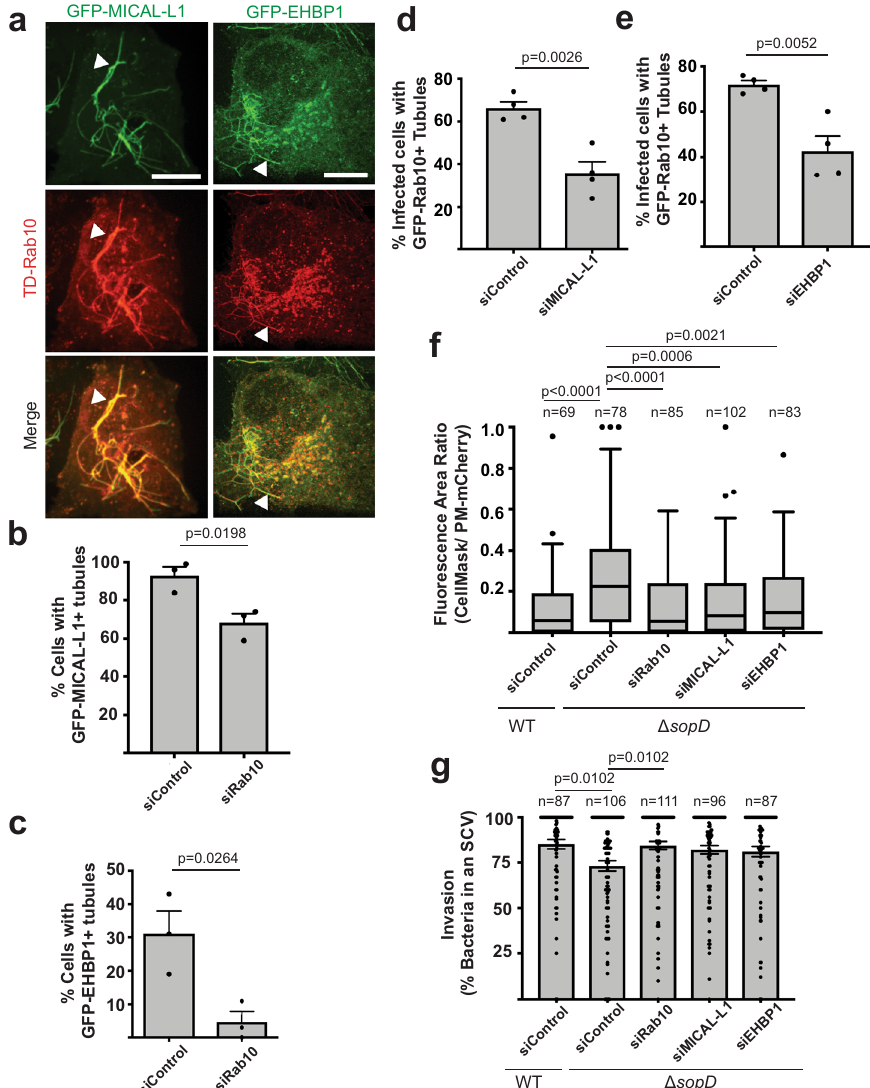
Fig. 4 Rab10 effectors limit scission of the plasma membrane during invasion by Δ sopD mutant S . Typhimurium. a Representative images of Henle 407 live cells co-transfected with TD-Rab10 and GFP-MICAL-L1 or GFP-EHBP1. Arrowheads indicate colocalization on tubules. Scale Bar, 10 μ m. Data are representative of three independent experiments. b , c Quanti fi cation of the presence or absence of ( b ) GFP-MICAL-L1 or ( c ) GFP-EHBP1 tubules under siControl or siRab10 knockdown conditions. At least 100 cells were quanti fi ed in three independent experiments. Data are means± S.E.M. P values determined using a two-tailed unpaired Student ’ s t test. d , e Henle 407 cells were transfected with the indicated siRNA and transfected 24 h later with GFP-Rab10, then infected with Δ sopD mutant S . Typhimurium and fi xed 30 min post-infection. In three independent experiments at least 50 infected cells were quanti fi ed for the presence or absence of GFP-Rab10 + tubules. Data are means ± S.E.M. P values determined using a two-tailed unpaired Student ’ s t test. f Henle 407 cells were transfected with the indicated siRNA (Rab10 siRNA #2, see “ Methods ” ) and then PM-mCherry 24 h later. Cells were then infected with BFP expressing WT or Δ sopD mutant Salmonella for 20 mins and labelled with CellMask. The fl uorescence area labelled with CellMask compared to that labelled with PM-mCherry is used as an index of sealing at the invasion site. Data are visualized with Tukey-style boxplots, where the boxes represent the 25th, 50th/median and 75th percentiles. The whiskers denote 1.5x the IQR (interquartile range) from the median. Points denote outliers beyond 1.5 x IQR. Statistical analysis was performed with one-way ANOVA. P -values and the number of independent cells used for measurements ( n ) are indicated in the fi gure. g Invasion represented as the percent of bacteria in Salmonella -containing vacuoles. The total number of bacteria that were positive for PM-mCherry at the invasion site was quanti fi ed and the proportion of these bacteria that were negative for CellMask was determined. These bacteria were in a sealed compartment that was considered an SCV and the number was used to represent the invasion ef fi ciency. Data are means ± S.E.M. Statistical analysis was performed with one-way ANOVA. P -values and the number of independent cells used for measurements ( n ) are indicated in the fi gure. SCV Salmonella -containing vacuole, GFP green fl uorescent protein, TD TdTomato. Source data are included in source data fi